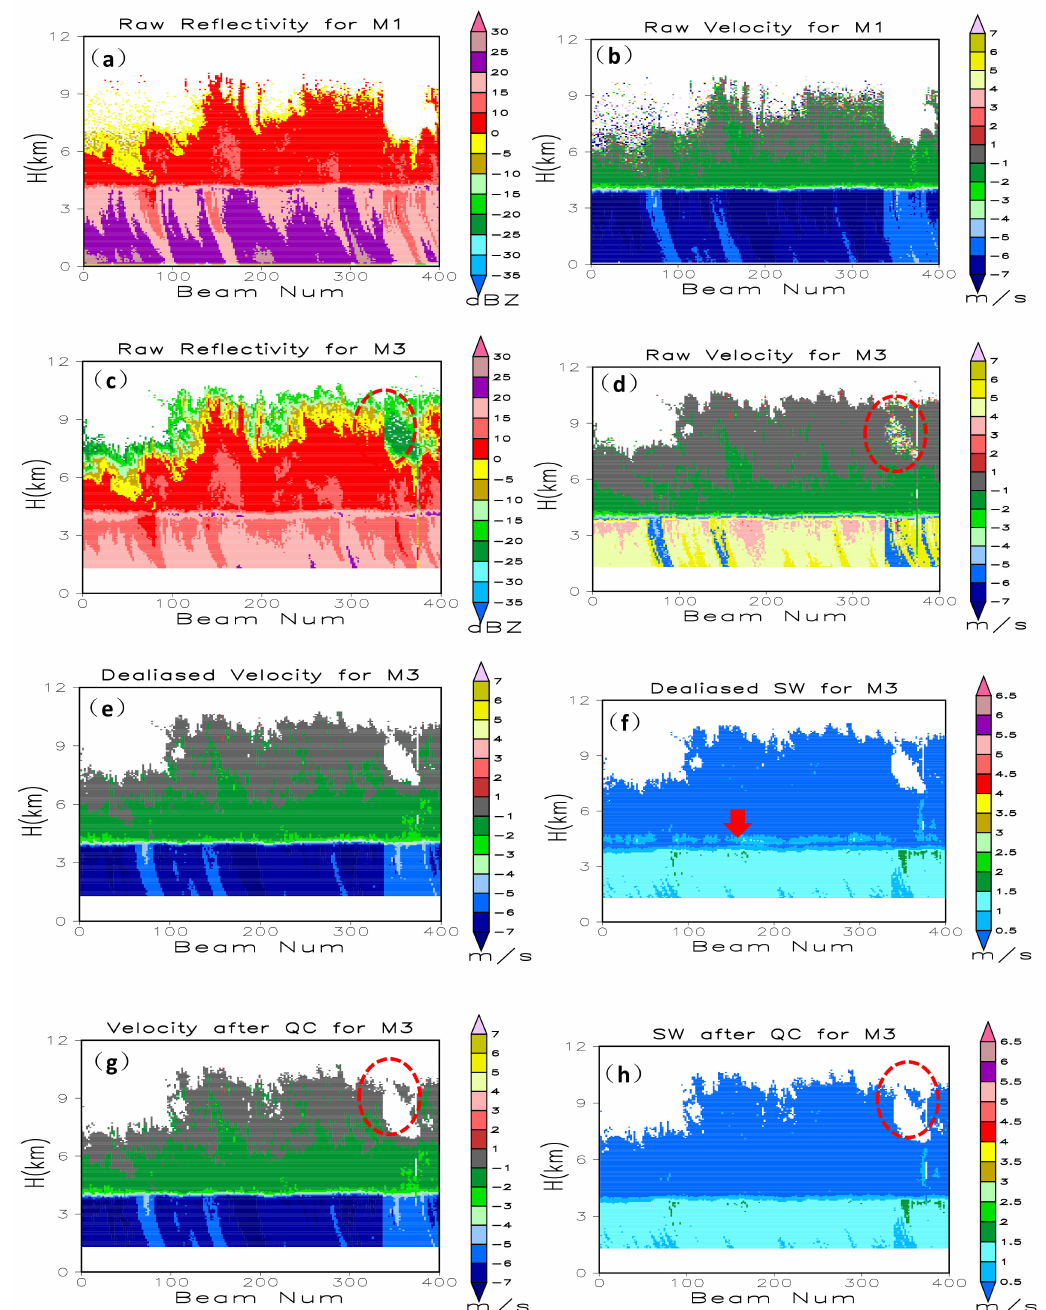
Figure 1. Time–height cross sections of 400 profiles of raw reflectivity and radial velocity measurements obtained using M1 ( a , b ) and M3 modes ( c , d ). Recalculated radial velocity and spectrum width after dealiasing only ( e , f ) and after dealiasing and artifact removal (QC) from M3 ( g , h ) for from 09:26 to 11:12 CST on May 21,